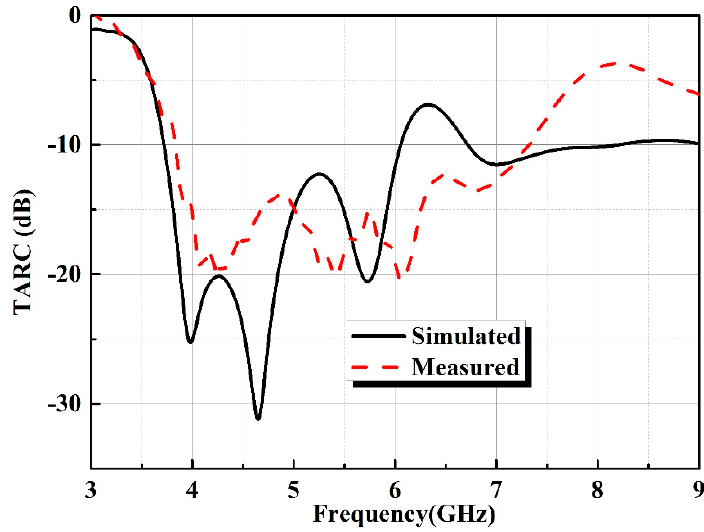
Figure 13. TARC curves for the proposed MIMO antenna system.